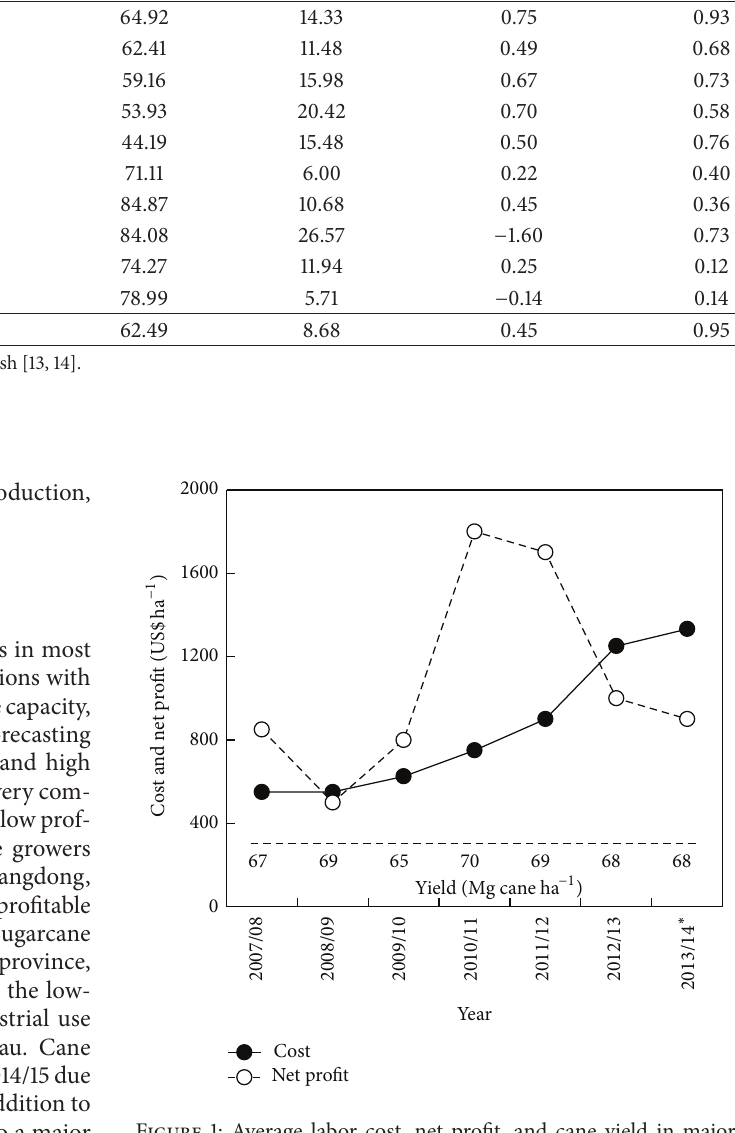
Figure 1: Average labor cost, net profit, and cane yield in major sugarcane production regions in China from 2007 to 2014. 2013/14 ∗ based on postestimate. Data are adopted from Anderson-Sprecher and Jiang